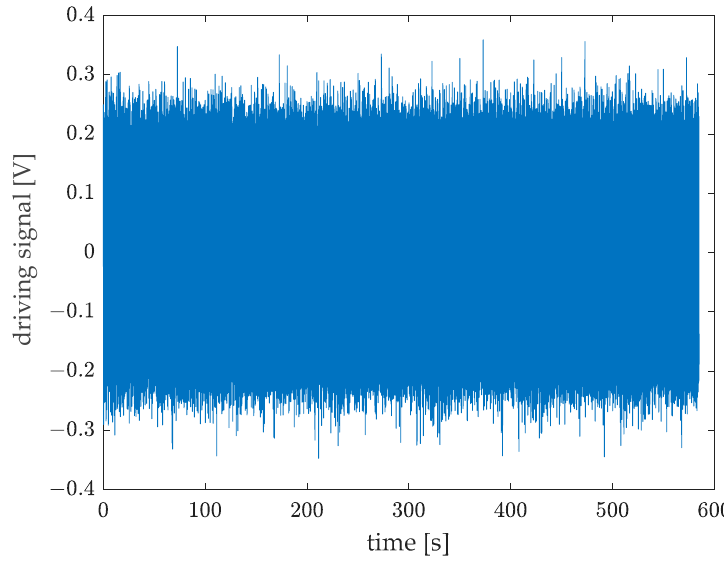
Figure 8. Shaker driving signal for random excitation.